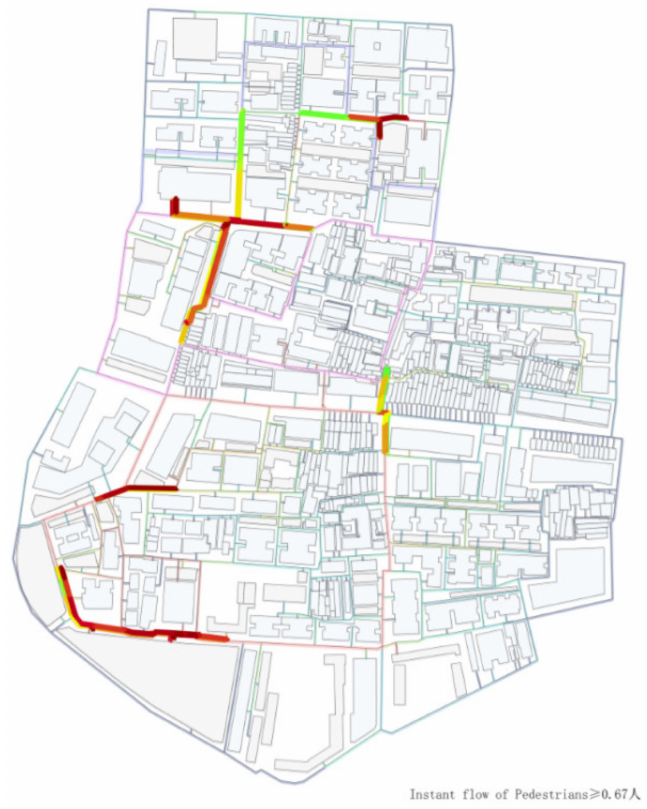
Figure 14. Pedestrian flow gathered routes of the elderly, young, and middle-aged people and